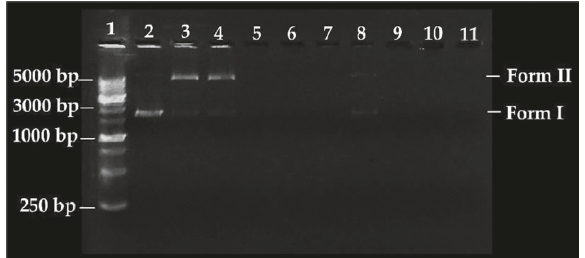
Figure 7: Agarose gel electrophoretic pattern of the pmCherry vector extracted from E. coli (5ng varying concentrations of compounds 1 and 2 . Lane 1: HyperLadder